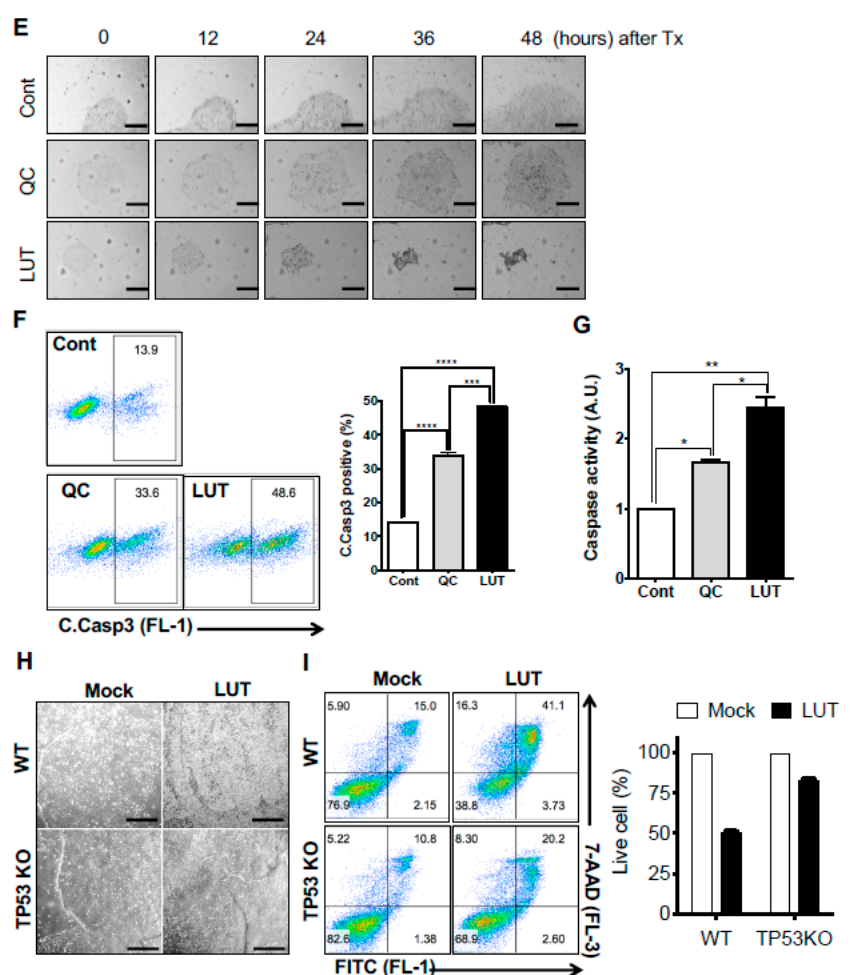
Figure 2. Potent stemotoxic effect of luteolin. ( A ) Flow cytometry for the Annexin V/7-AAD assay (left) and graphical presentation of live cells (Annexin V and 7-AAD negative population, right) 24 h after treatment with indicative concentrations of quercetin (QC), luteolin (LUT) or apigenin (API) ( n = 2). ( B ) Immunoblotting analysis for PARP-1 (F: full and C: cleaved), cleaved caspase 3 (C.Casp3), cleaved caspase 9 (C.Casp9) at 24 h after indicative concentration of each flavonoid, α -tubulin for equal protein loading. ( C ) Microscope images of hESCs at 24 h after treatment of 12.5 μ M of each flavonoid (scale bar = 200 μ m). ( D ) Flow cytometry for Annexin V/7-AAD assay (left) and graphical presentation of live cells (Annexin V and 7-AAD negative population, right) at 24 h after indicative concentration of each flavonoid. Treatment of etoposide (Eto) was shown as a positive control of cell death ( n = 2). p < 0.0001 (****). ( E ) Microscope images of hESCs at 48 h after treatment with 12.5 µ M of each flavonoid (scale bar = 200 µ m). ( F ) Flow cytometry analysis for cleaved caspase 3 (left) and graphical presentation of cleaved caspase 3 positive population after treatment with 12.5 µ M of each flavonoid ( n = 2). ( G ) Graphical presentation of caspase 3 activity at 24 h after treatment of 12.5 µ M of each flavonoid ( n = 2). p < 0.05 (*), p < 0.01 (**), p < 0.001 (***), p < 0.0001 (****). ( H and I ) Microscope images (scale bar = 200 µ m), ( H ) and flow cytometry ( I ) of hiPSCs (WT: wild-type and TP53KO: p53 − / − hiPSCs) at 24 h after treatment of 12.5 µ M of luteolin (LUT), graphical presentation of live cells was shown (right) ( n =